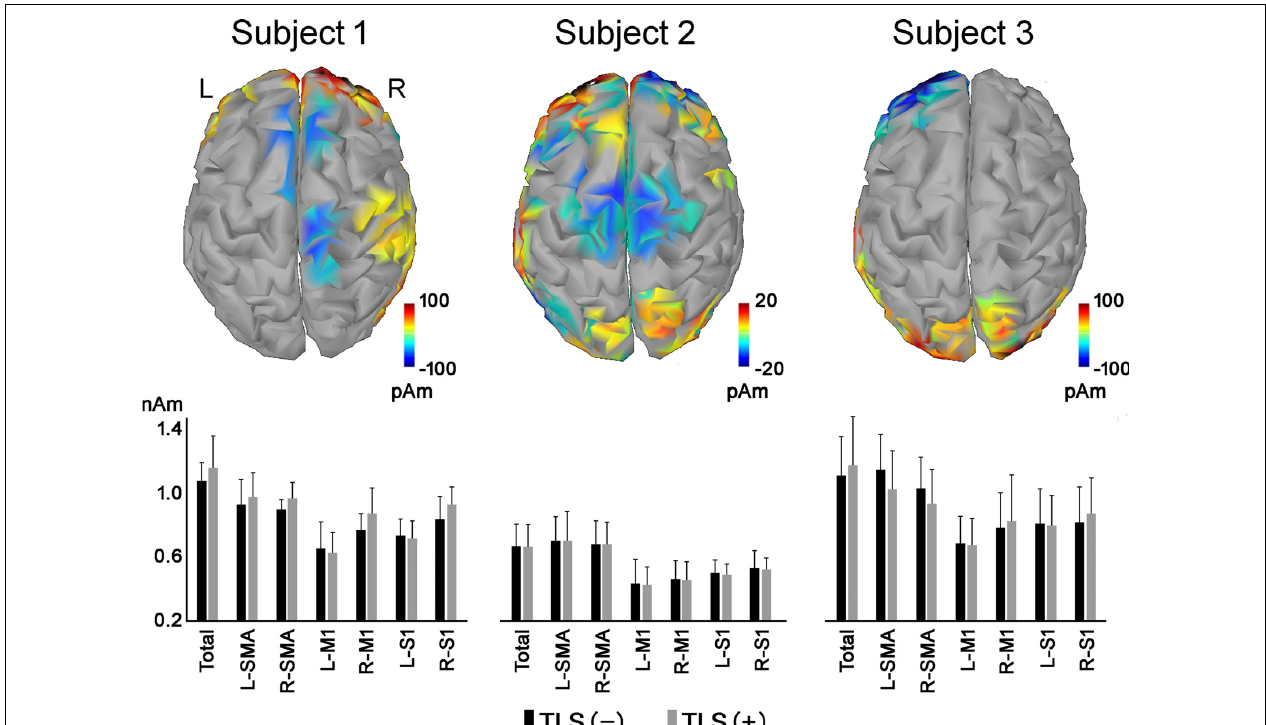
FIGURE 1 | Differences in mean cortical current during motor imagery tasks without and with TLS activation [(movement imagery with TLS activation)—(movement imagery without TLS activation)]. Yellow to red and blue indicates increased and decreased current (pAm) during the task with and without TLS activation, respectively. Mean cortical current density in the total cortex (Total), SMA, M1, and S1 areas was shown in the bar graph below. Black and gray bars indicate cortical current density during movement imagery without and with TLS activation, respectively. Each vertical bar indicates a standard deviation. TLS, Tacit Learning System; SMA, supplementary motor area; M1, primary motor cortex; S1, primary somatosensory cortex.